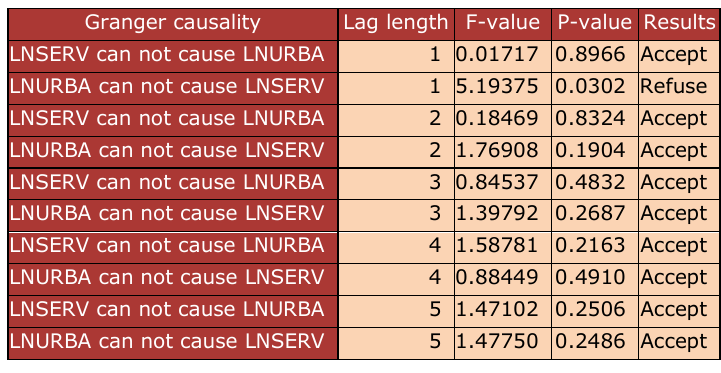
Table 4. Granger causality test between various